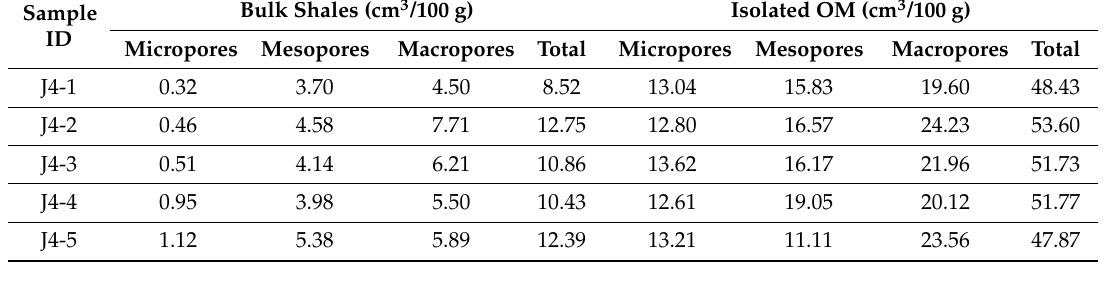
Table 4. Pore volumes of isolated OM and shale obtained from low pressure gas (CO 2 and N 2 ) adsorption (LPGA) data.